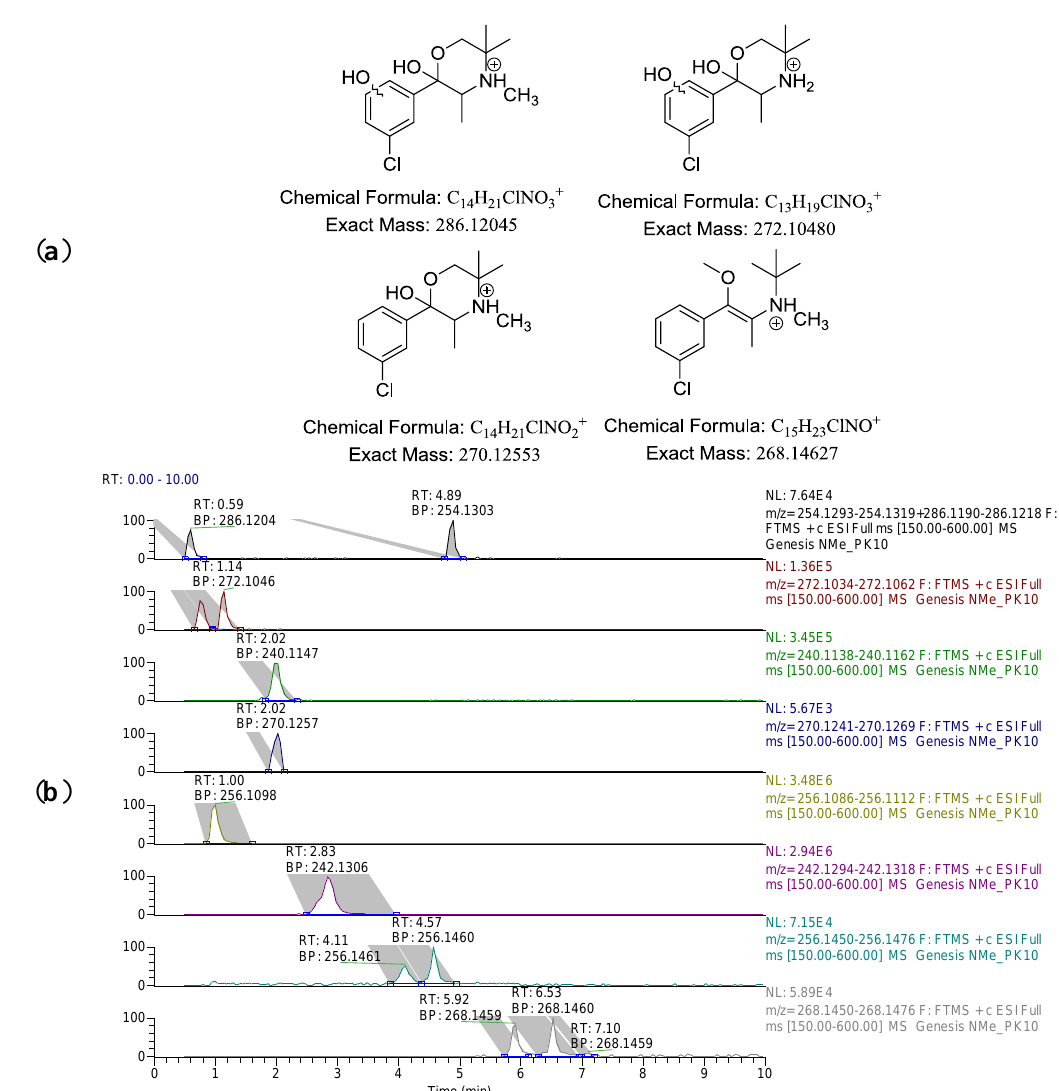
prodrug dose. Bupropion (2.02), threo- hydrobupropion (2.83), hydroxybupropion